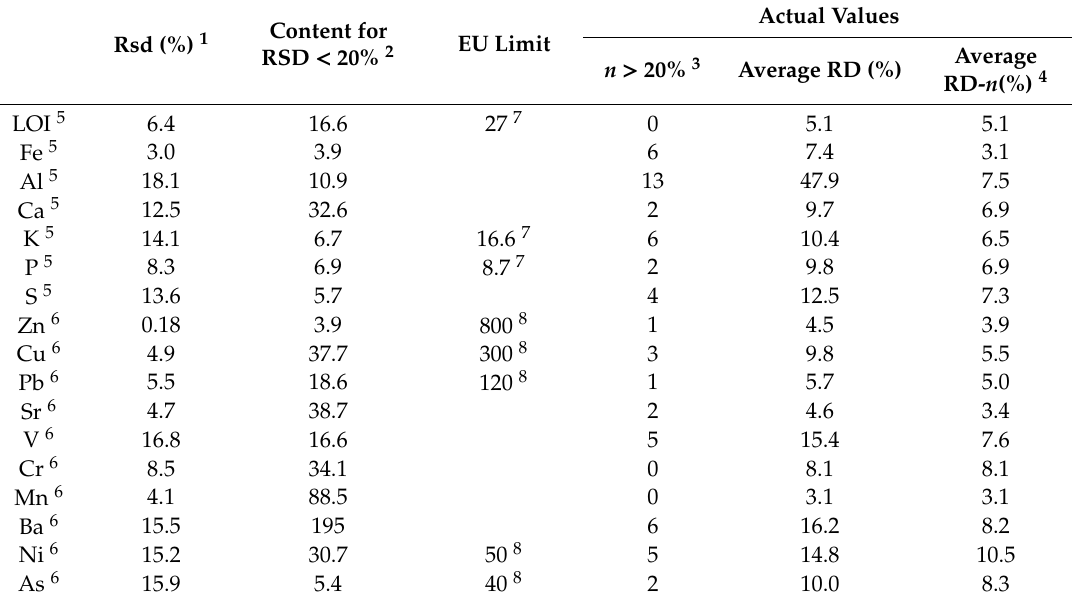
Table 7. Deviations between actual and predicted